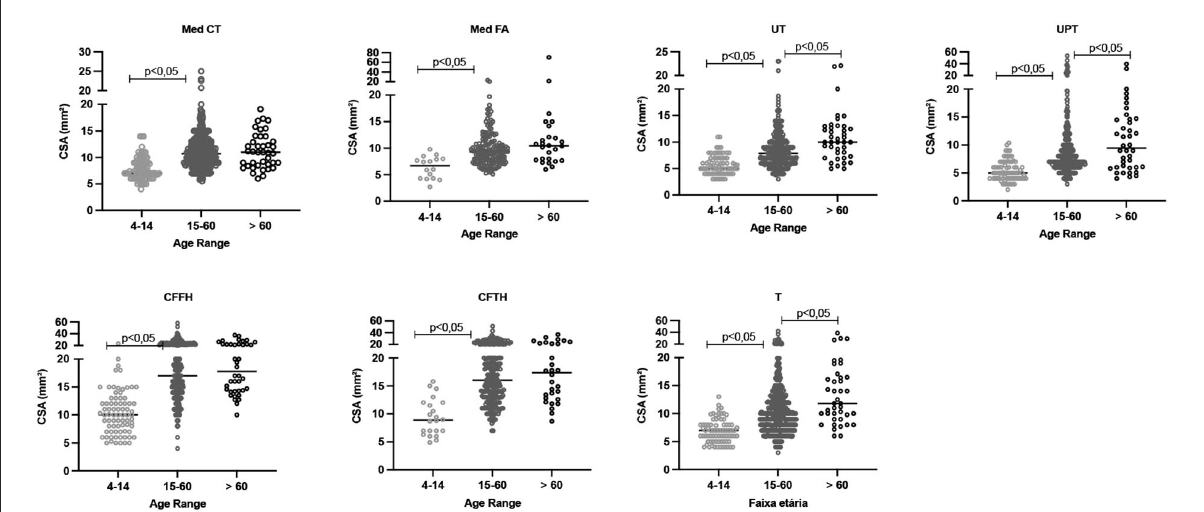
FIGURE3 Distribution of absolute CSA (mm 2 ) values for the neural sites assessed in patients with leprosy according to age range, with differences highlighted ( p < 0.05). CSA, cross-sectional area; Med CT, median carpal tunnel; Med FA, median forearm; UT, cubital ulnar tunnel; UPT, cubital ulnar pretunnel; CFFH, common fibular in the fibula head; CFTH, common fibular thigh; T, tibial.